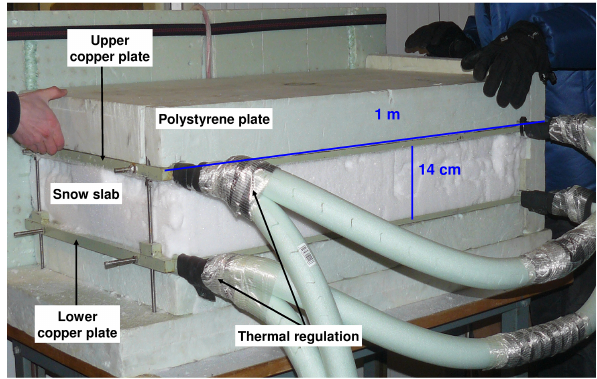
Figure 1. Photograph in cold room of the apparatus designed to control and monitor temperatures at the top and bottom of a snow slab. The front and side vertical polystyrene plates were removed from the device for visualization purposes.